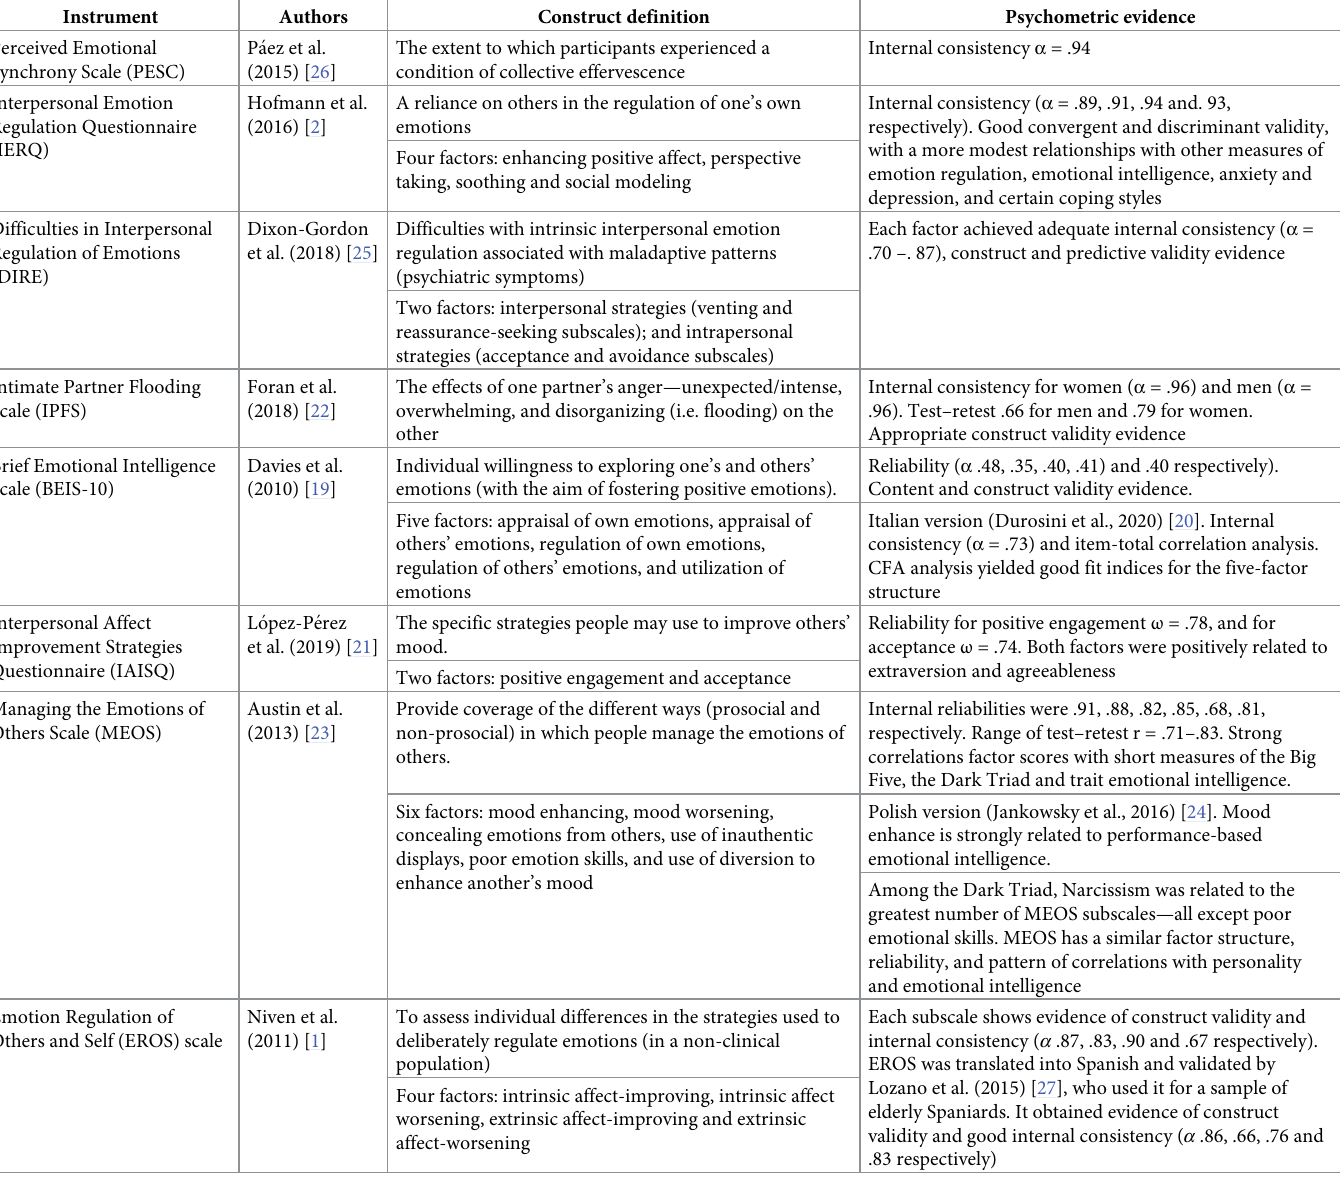
Table 1. Instruments that evaluate constructs associated with interpersonal emotion